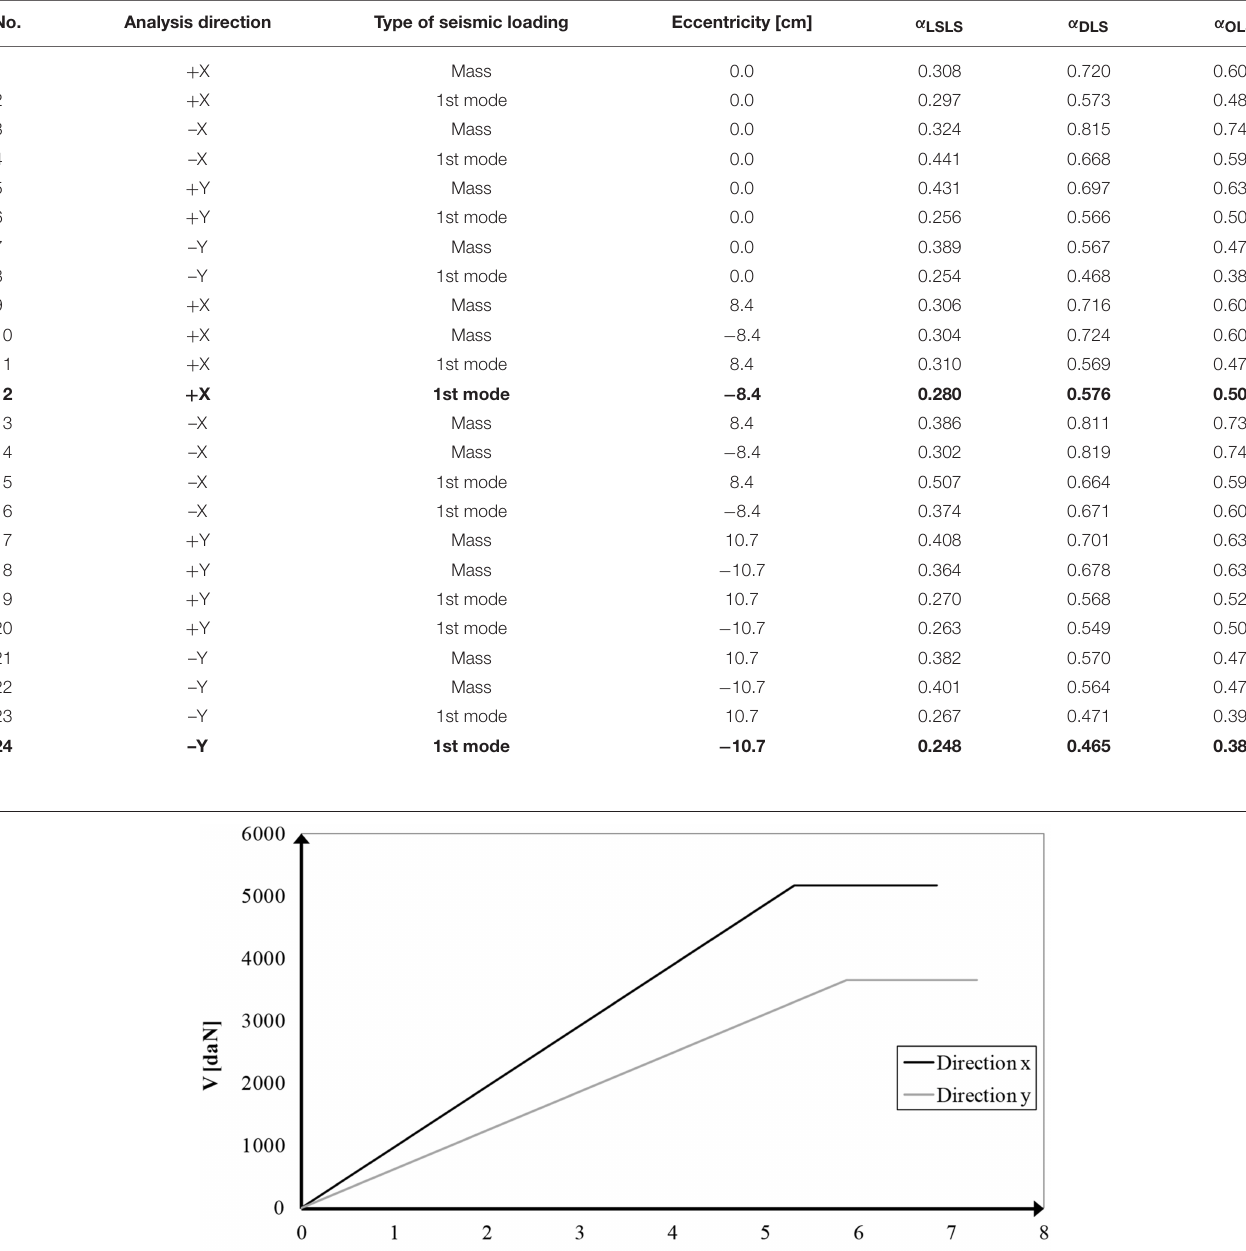
TABLE 2 | Pushover analysis results on the isolate bell tower. No.